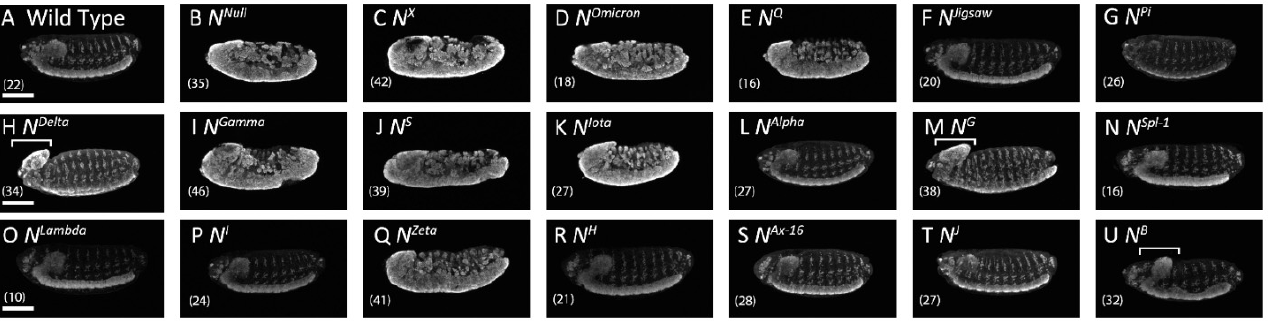
Figure 2. Notch alleles that disrupted lateral inhibition in the embryonic central nervous system. Lateral views show the embryonic nervous system, stained with an anti-Elav antibody (white), in ( A ) wild-type Drosophila and hemizygotes for ( B ) N 55 e 11 , an amorphic allele of Notch ; ( C ) N X , ( D ) N Omicron , ( E ) N Q , ( F ) N Jigsaw , ( G ) N pi , ( H ) N Delta , ( I ) N Gamma , ( J ) N S , ( K ) N Iota , ( L ) N Alpha , ( M ) N G , ( N ) N Spl − 1 , ( O ) N Lambda , ( P ) N I , ( Q ) N Zeta , ( R ) N H , ( S ) N Ax − 16 , ( T ) N J , and ( U ) N B . White brackets show the regions with a brain deformation phenotype. The number of embryos analyzed is shown in parentheses. Scale bars: 100 μ m.